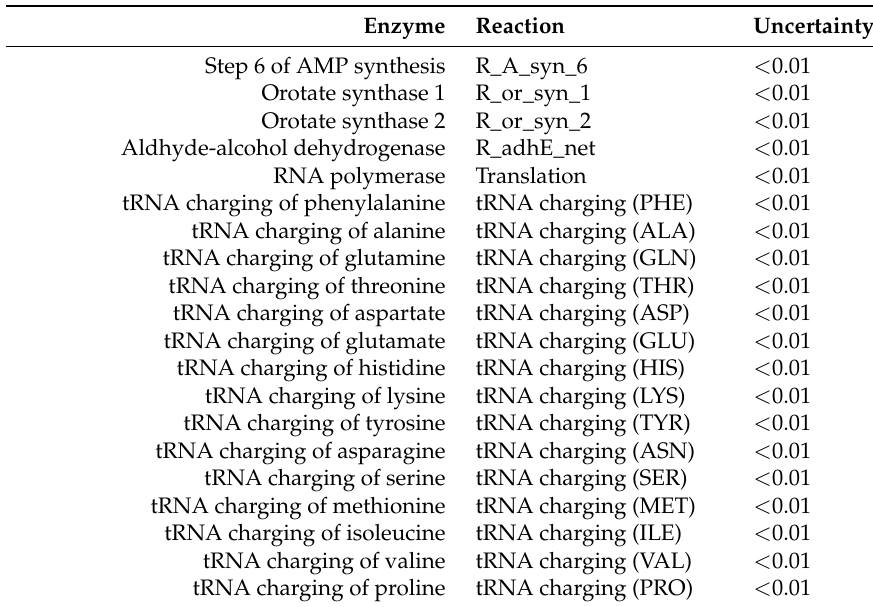
Table 3. Flux uncertainty calculated using flux variability analysis for the base synthetic dataset during the second production phase (1 h to 3 h), normalized to the glucose consumption